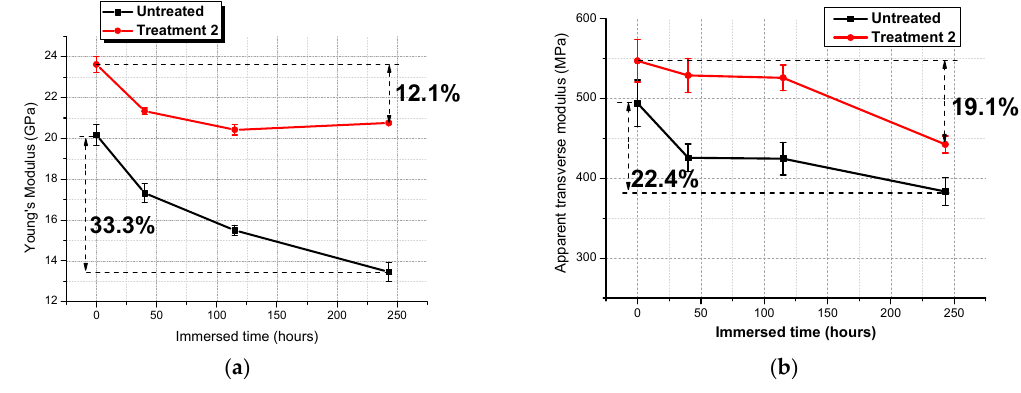
Figure 10. Change of modulus in fiber direction after water absorption: ( a ) retention of Young’s modulus in fiber direction; and ( b ) retention of transverse modulus. (Error bars indicate standard deviation).